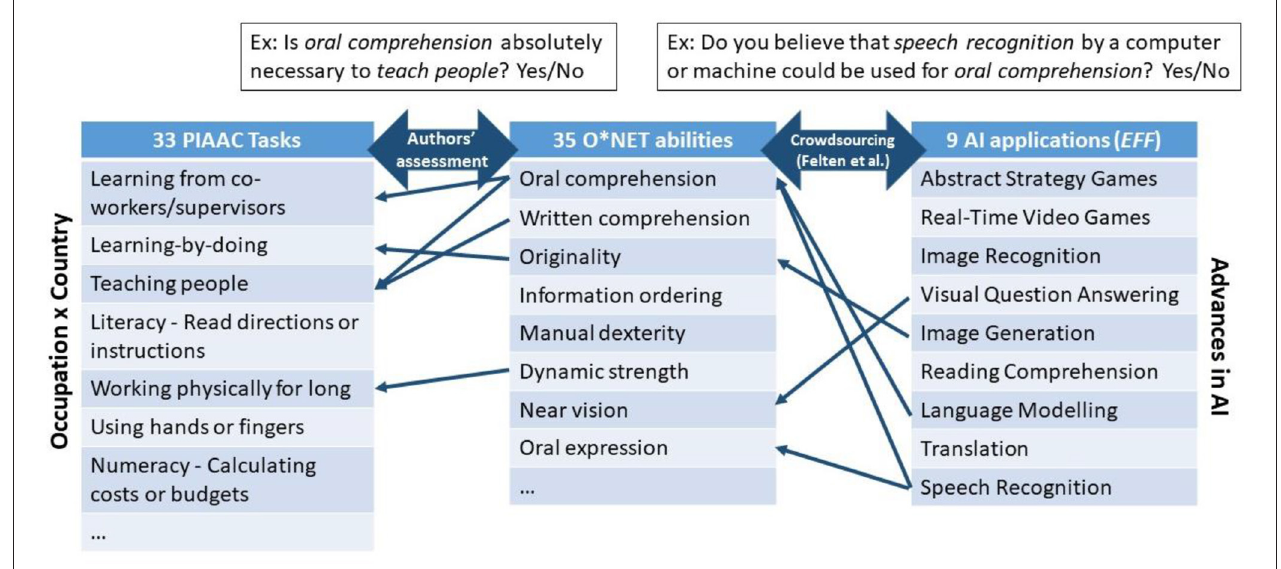
FIGURE 2 | Construction of the measure of occupational exposure to AI. Adaptation from Felten et al. (2018) to 23 OECD countries. The authors link O*NET abilities and PIAAC tasks manually by asking whether a given ability is indispensable for performing a given task. The link between O*NET abilities and AI applications (a correlation matrix) is taken from Felten et al. (2019). The matrix was built by an Amazon Mechanical Turk survey of 200 gig workers per AI application, who were asked whether a given AI application can be used for a certain ability. The correlation matrix between applications and abilities is then calculated as the share of respondents who thought that a given AI application could be used for a given ability. This chart is for illustrative purposes and is not an exhaustive representation of the links between the tasks, abilities and AI applications